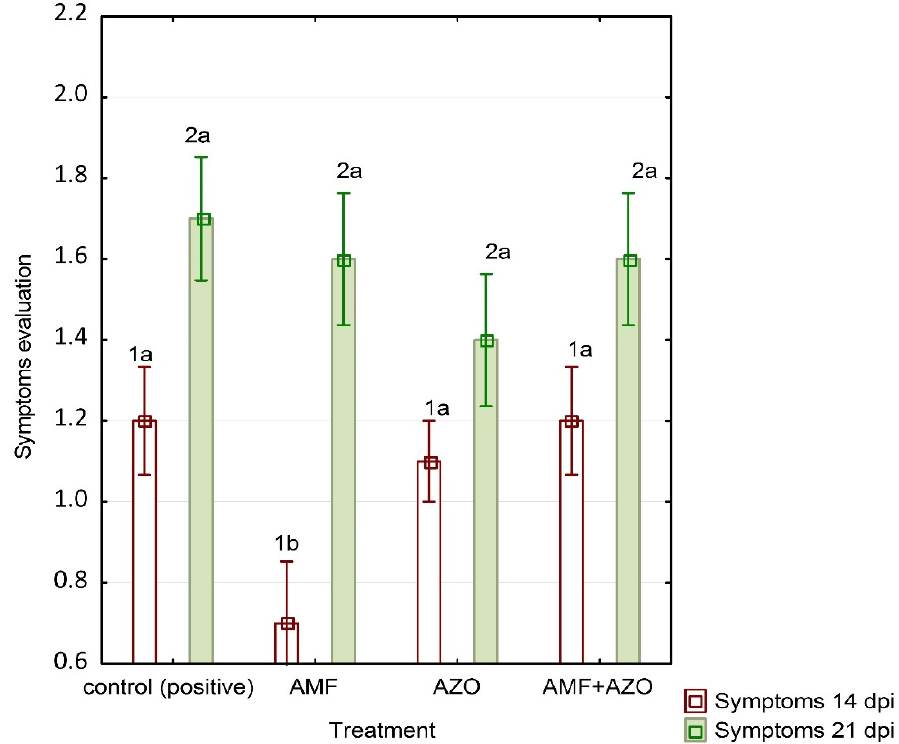
Figure 2. Means (n = 10) ( ± SE) of symptom evaluation on ToBRFV inoculated plants at 14 and 21 dpi, separated into homogenous groups (1a, 1b and 2a) according to Fisher ´ s LSD test. Explanatory notes: AMF-arbuscular mycorrhizal fungus ( Funneliformis mosseae ), AZO- Azospirillum brasilense .